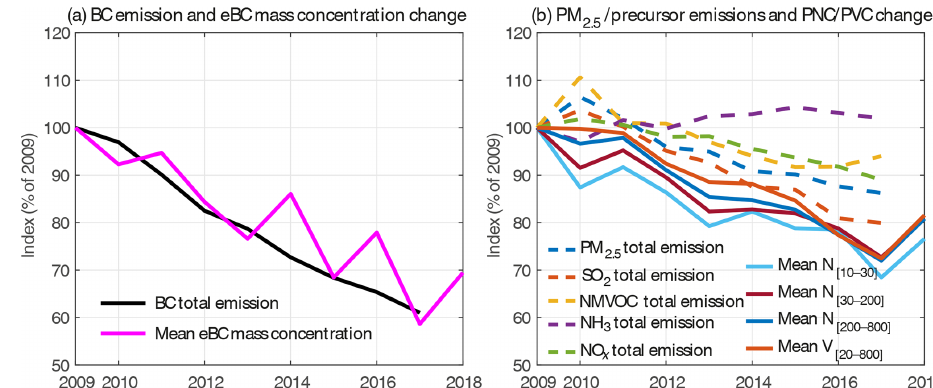
Figure 3. Long-term change index (percent of average in 2009) of measured parameters at the regional background and mountain station sites and total emissions in Germany: (a) measured eBC mass concentration and BC emission; (b) measured N [ 10 − 30 ] , N [ 30 − 200 ] , N [ 200 − 800 ] , and V [ 20 − 800 ] and emission of PM 2 . 5 , SO 2 , NMVOC, NH 3 , and NO x